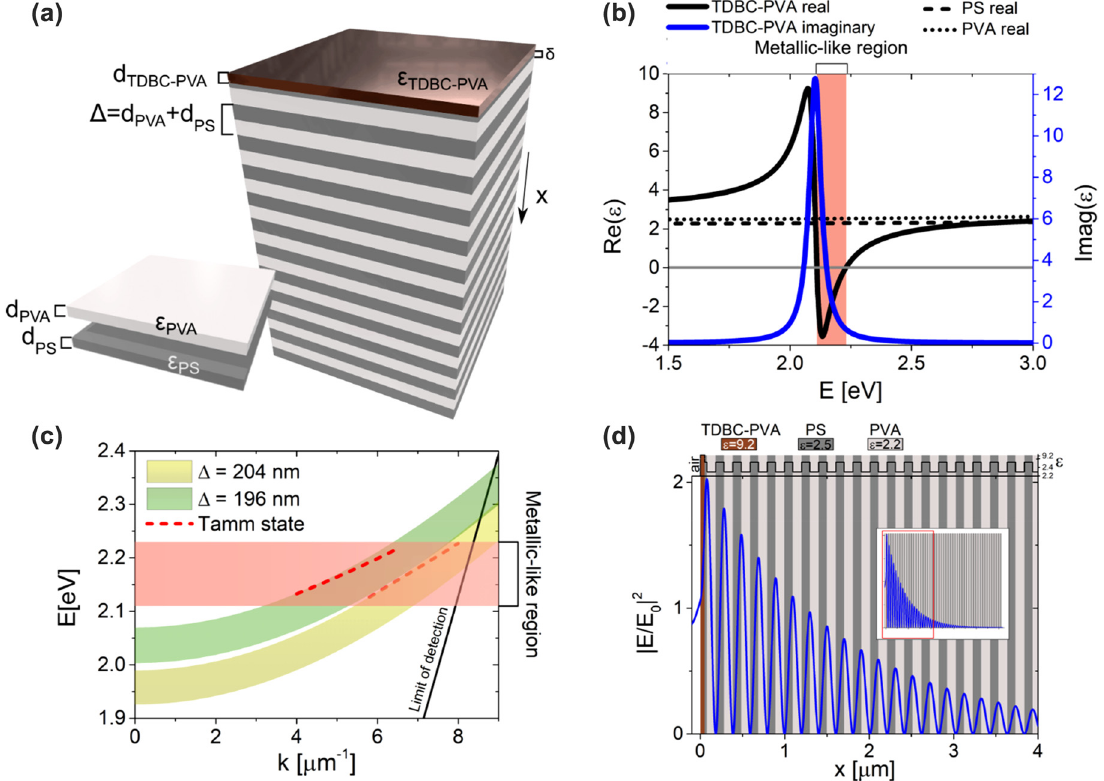
Figure 1: OTS-supported structure. (a) Schematic representation of the OTS structures consisting of two reflective sub-structures. The structure has in total 102 layers (100 layers for the DBR, a thin adhesion PS layer and a TDBC-PVA layer). (b) The complex dielectric constant of PVA (dash black line), PS (dotted black line) and TDBC-PVA films (blue and black continuous lines). The imaginary part of the dielectric constant for PVA and PS is zero in this wavelength range. (c) The s-polarised photonic band gap of DBRs with Δ = 204 nm or 196 nm are indicated by yellow and green regions, respectively. The high reflectance band of the TDBC-PVA film is represented by the red region. The OTS dispersion curves of the two structures are indicated by the dashed red line. (d) Electric field intensity within the OTS structure for the sample Δ = 204 nm at E = 2.21 eV and k = 7.91 μ m − 1 ( 𝜃 = 45 ◦ ). Light is incident from the air towards a glass substrate where the DBR was